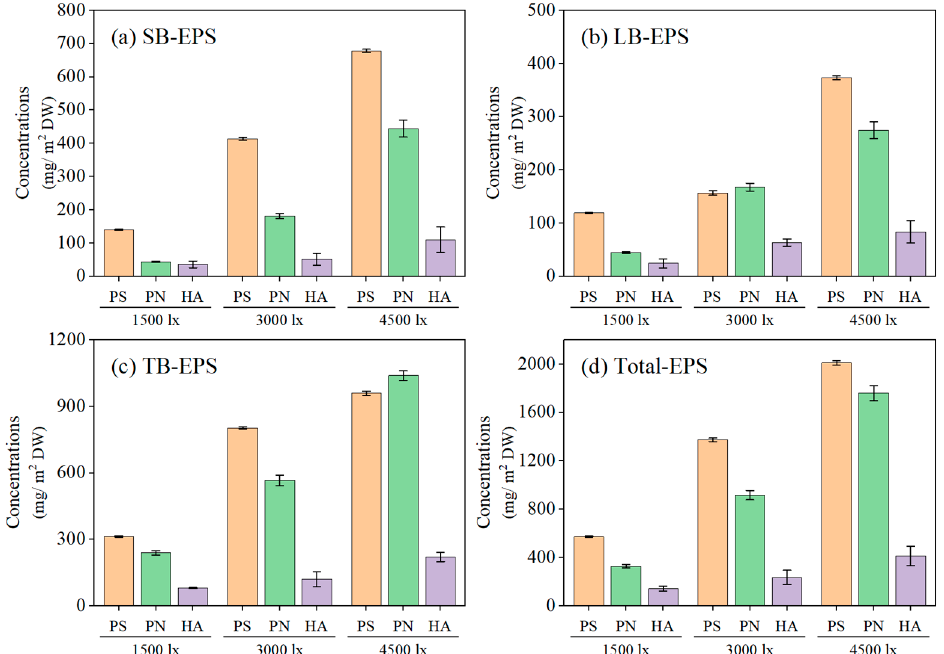
Figure 2. The concentrations of EPS components in mature phototrophic biofilms cultivated under varying light intensities: ( a ) soluble EPS (SB-EPS), ( b ) loosely bound EPS (LB-EPS), ( c ) tightly bound EPS (TB-EPS), and ( d ) total-EPS. The EPS components were humic acid (HA), protein (PN) and carbohydrate (PS).